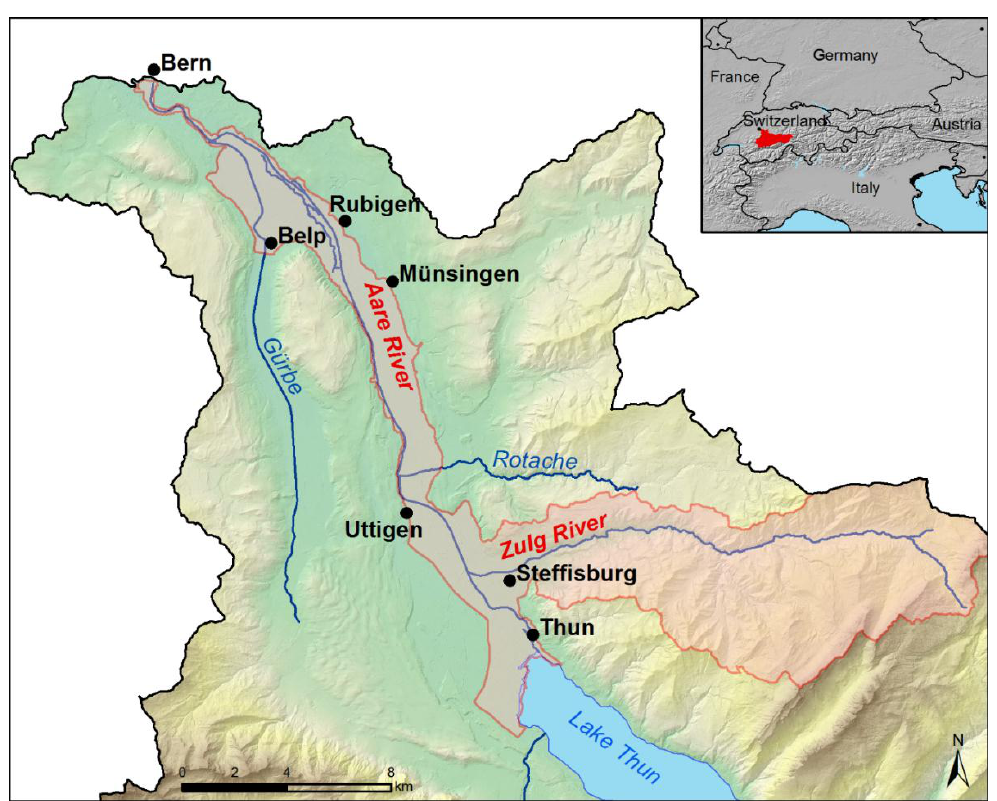
Figure 3. Overview of the study area. Background data: Canton of Bern.